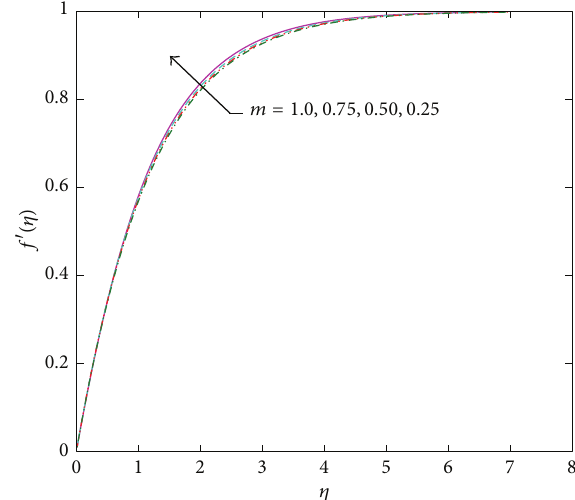
Figure 12: The effect of 𝑚 on velocity profile when 𝑘 1 = 1.0 , 𝜆 𝑇 = 0.2 , and Pr = 1.0 .